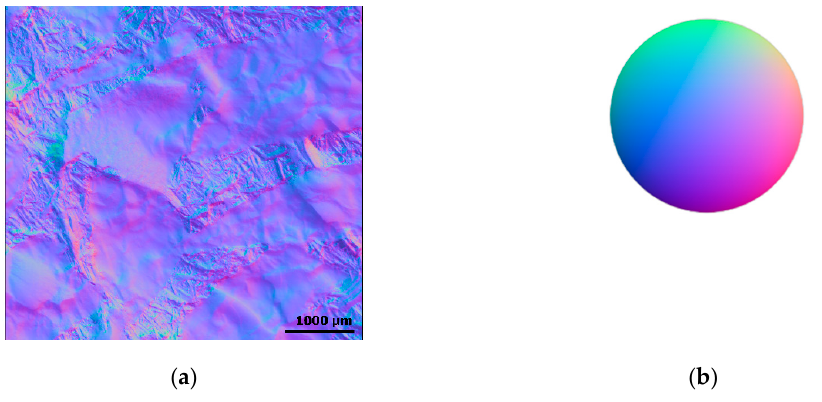
Figure 5. Rendering of a normal map (gradients or slopes) of a measurement of surface from material 3 ( a ). The direction of the vector is indicated by the color mix, where Red = X, Green = Y and Blue = Z ( b ). The eigenvalues ( K 1 , K 2 ), are the principal curvatures. These are the extreme values, maximum and minimum, of curvatures locally. Their orientations, the principal directions, are